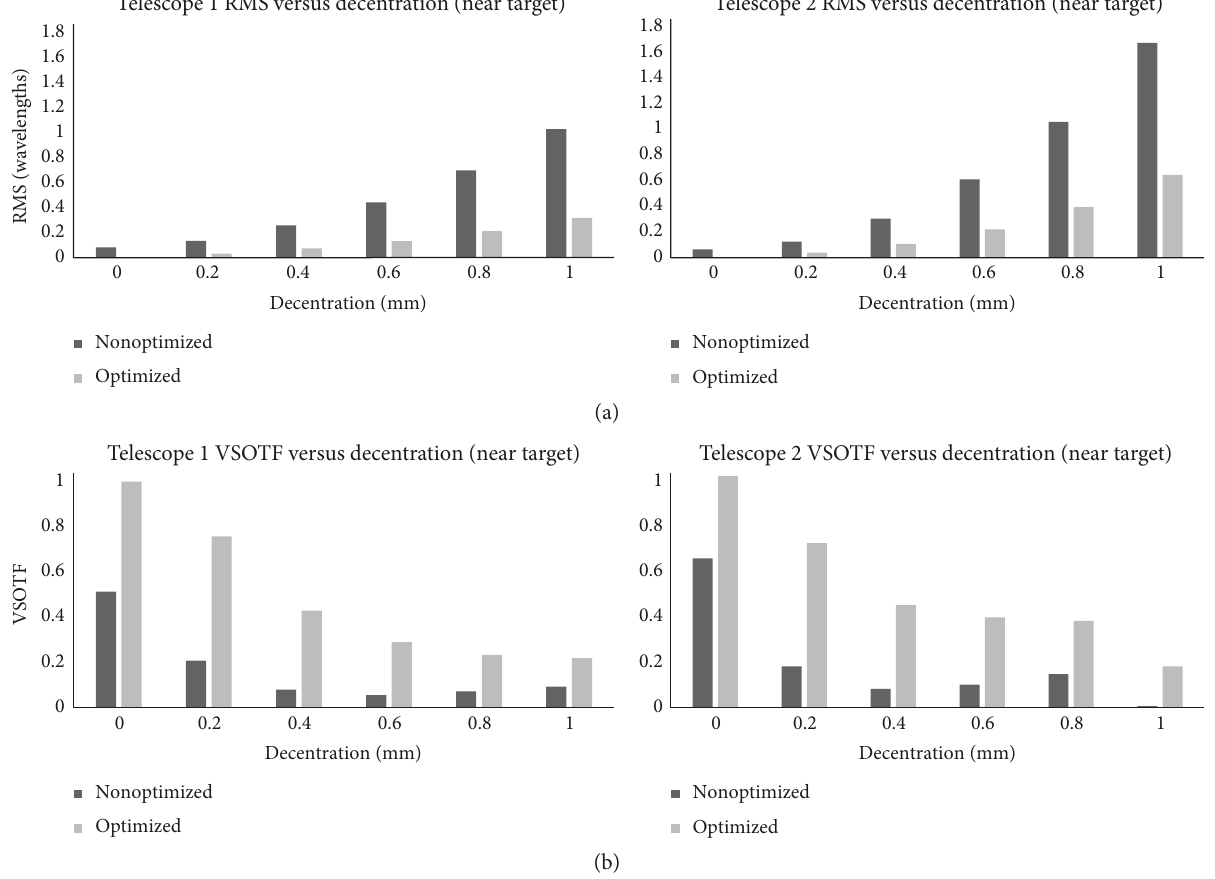
Figure 7: Telescope root mean square (RMS) wavefront error (a) and visual Strehl ratio (VSOTF) (b) versus decentration of the anterior lens for near target